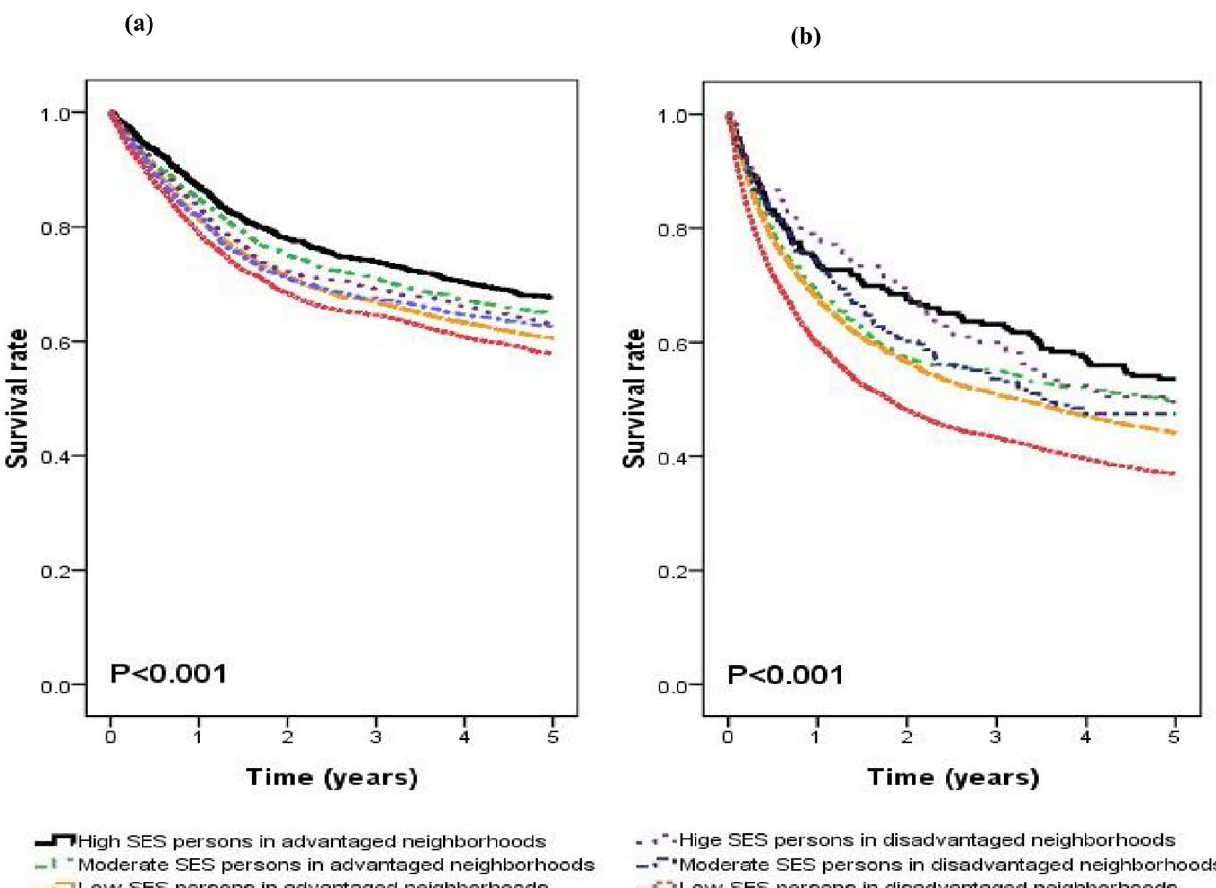
Figure 2. The combined effect of individual and neighborhood SES on cancer survival rates in patients aged less than 65 years (a) and those aged 65 years and above (b).